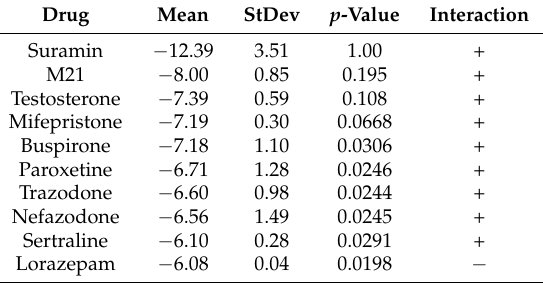
Table 8. Interaction between common drugs used to treat GWI symptoms and TNF- α . Mean binding energy and standard deviation are in units of kcal/mol. A t -test was used to compare with the known binder suramin. (+) indicates putative binding, ( − ) indicates no putative